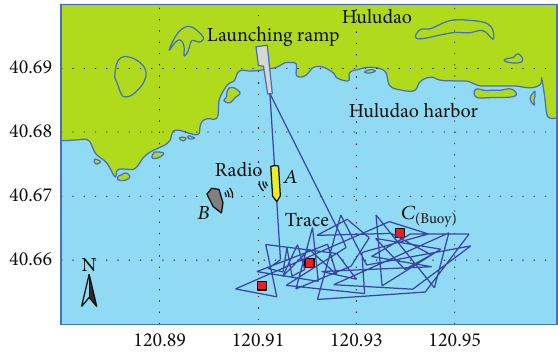
Figure 8: Voyage map of sea trial.